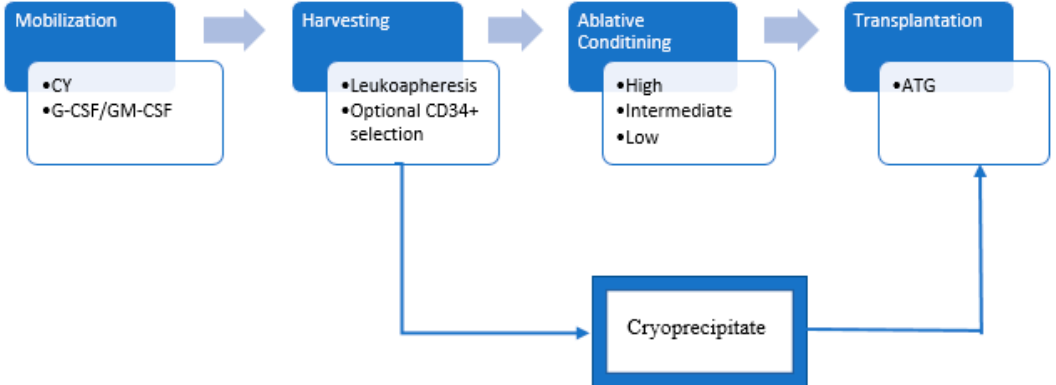
Figure 1. Immunoablation followed by autologous hematopoietic stem cell transplantation. First, HSC are mobilized, typically from peripheral blood, by using granulocyte colony-stimulating factor (G-CSF) or granulocyte-macrophage colony-stimulating factor (GM-CSF), with or without cyclophosphamide (CY). The HSC are then harvested and cryopreserved until the patient is ready for transplantation. The HSC can be positively selected for CD34 + cells ex vivo. The next step is to eliminate autoreactive cells (ablative conditioning) using either a high-, intermediate (BEAM), or low-intensity regimen. After the conditioning regimen, the cryopreserved cells are thawed and then infused back into the patient. Anti-thymocyte globulin (ATG) is administered before or after the aHSC infusion to primarily